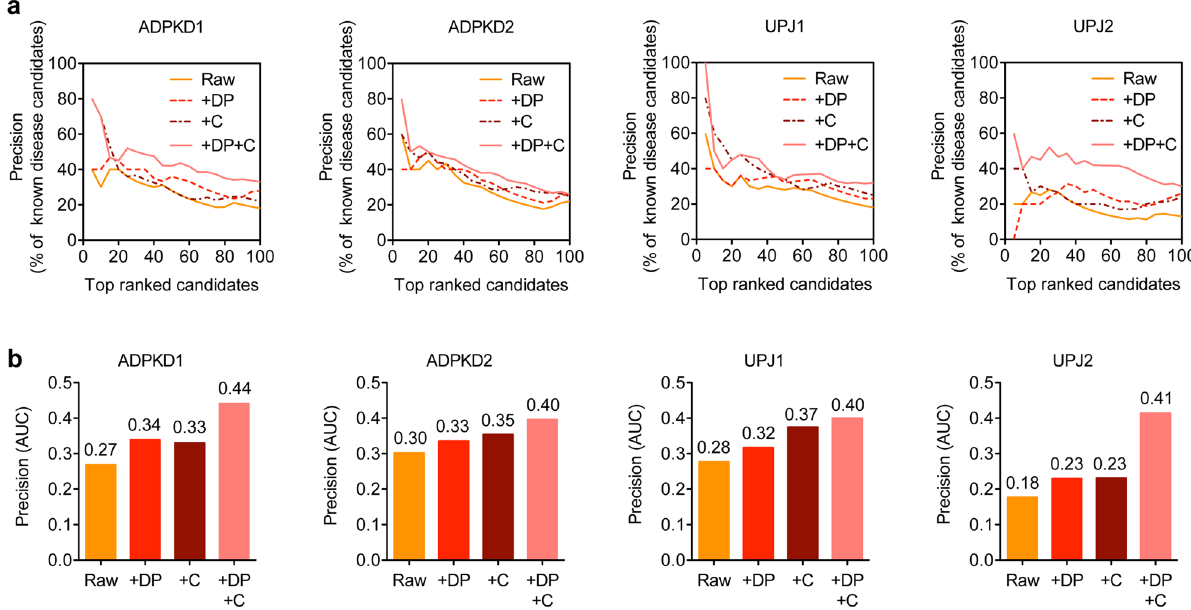
Figure 3. Performance of PRYNT depending on PPI network contextualization. ( a ) The precision was calculated based on the percentage of reference ADPKD or UPJ disease candidates that were prioritized in the top 100 candidates ranked by PRYNT in the four datasets using either the raw PPI network (Raw) or the PPI networks contextualized by the addition of deregulated urinary proteins regardless of their confidence level (+DP), by the management of clique sub-graphs (+C) or by the combination of both (+DP +C). ( b ) The corresponding area under the precision curve (AUC) was calculated in the four datasets. Graphs were designed using GraphPad Prism version 5.0 for Mac, GraphPad Software, San Diego, California USA, http://www.graph pad.com. DP: deregulated protein; C: